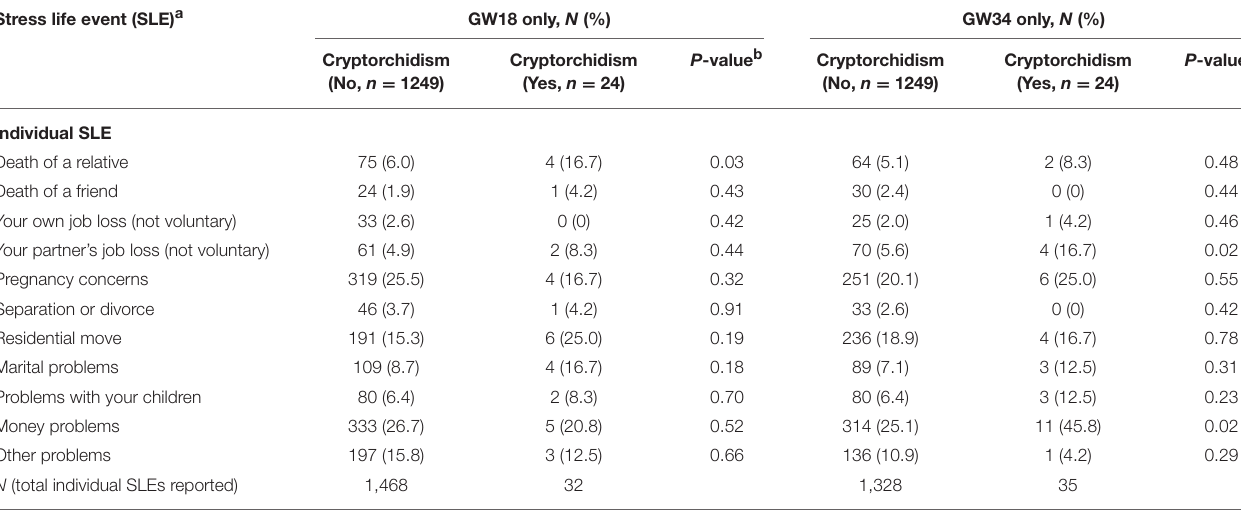
TABLE 1 | Type, timing, and number of stressful life event (SLE) exposures of 1,273 sons according to cryptorchidism. Stress life event (SLE)